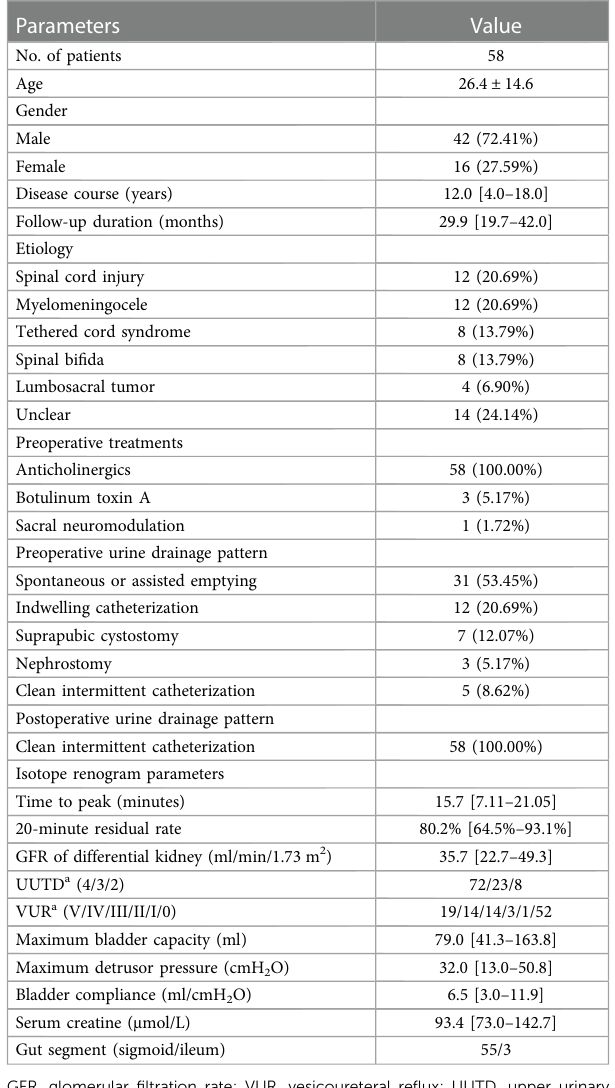
TABLE 1 The clinical characteristics of